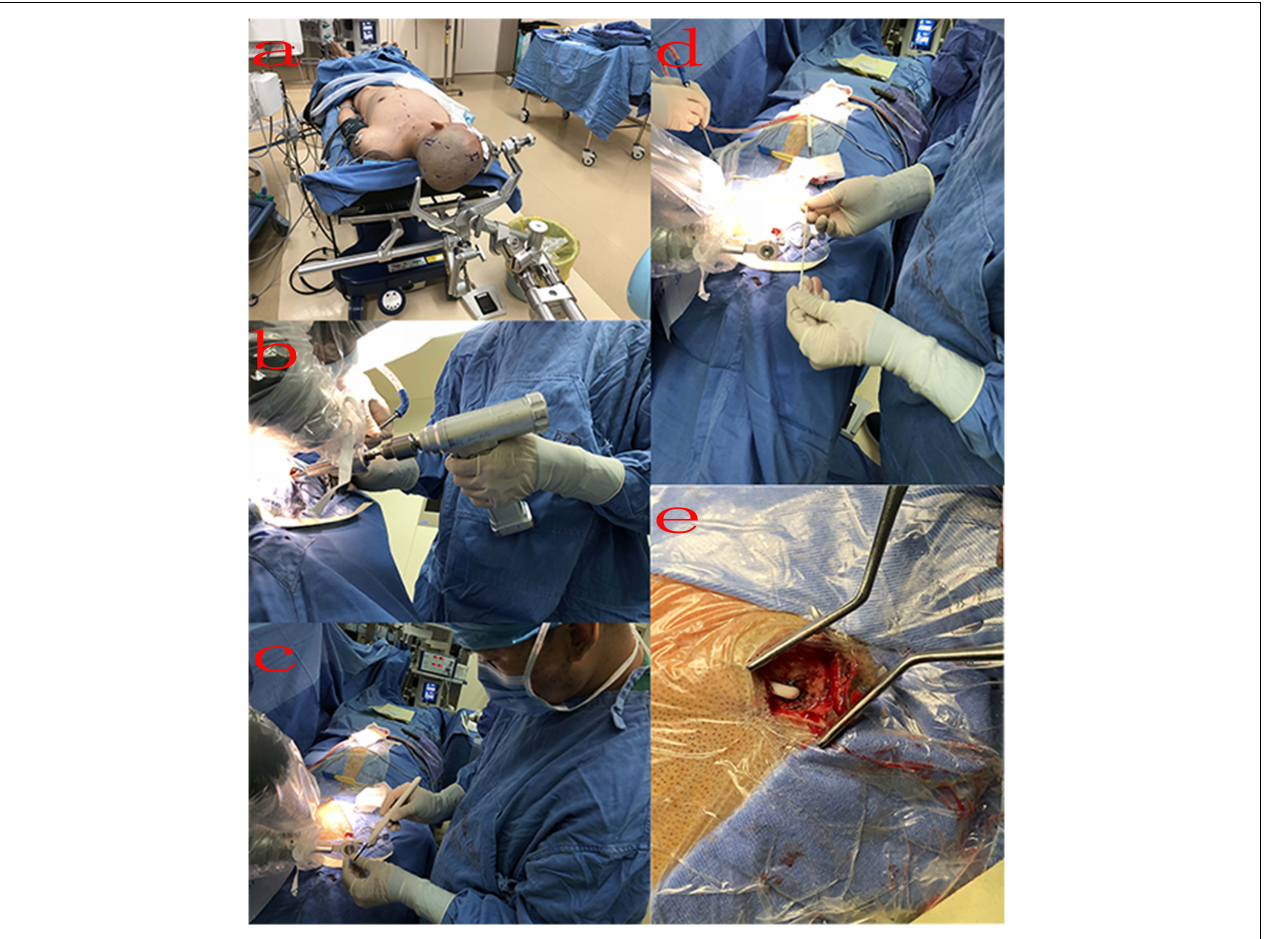
FIGURE 3 | Intraoperative process: (A) surgical position: the patient was placed in the supine position, and the Mayfield headholder was positioned and secured to the trolley with a mechanical support arm; (B) surgeon drills a bone hole; (C) penetrate the dura using a monopolar electric knife; (D) implant drainage tube; (E) after implantation, the drainage tube was placed under the